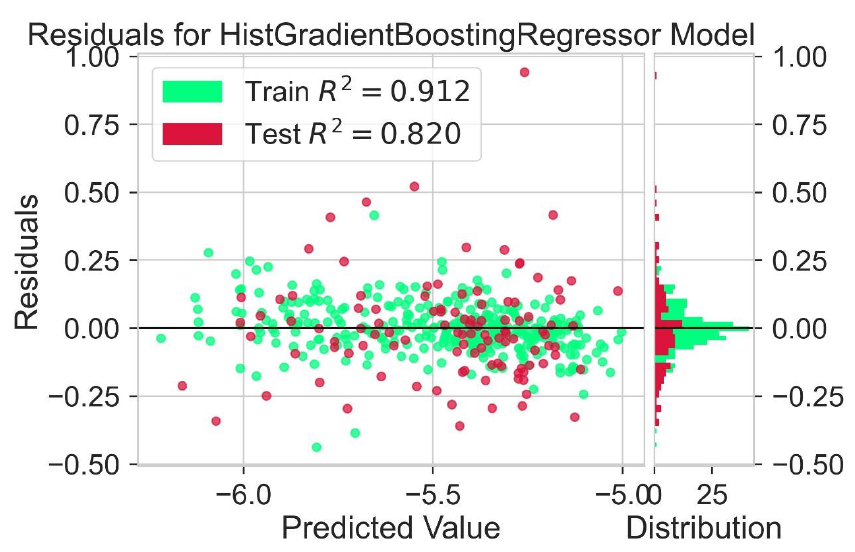
Figure 5. Residual for LGBM regression model.